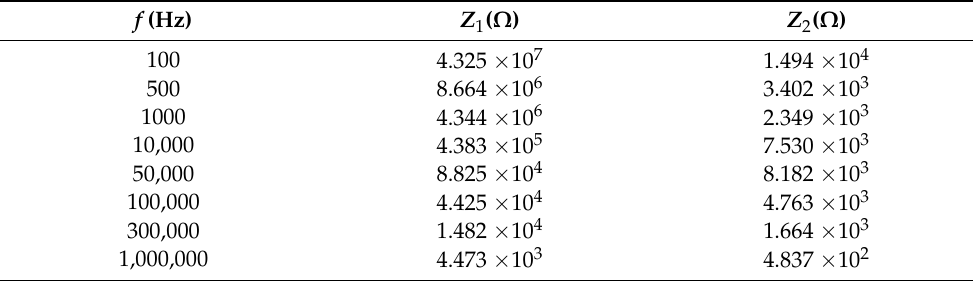
Table 7. Modules of the obtained primary ( Z 1 ) and secondary ( Z 2 ) impedances for LPVT A at 10 V at room